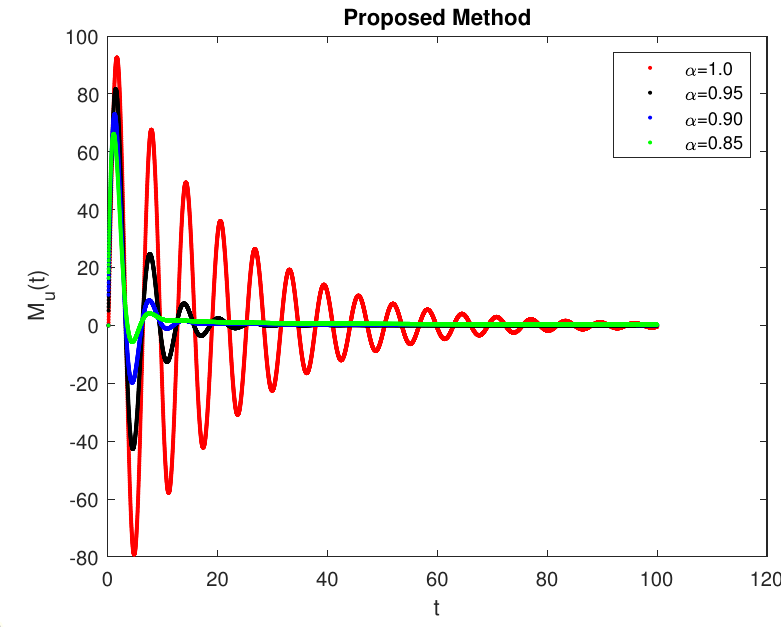
Figure 1: Numerical simulations for τ = 1 for ABC derivative.